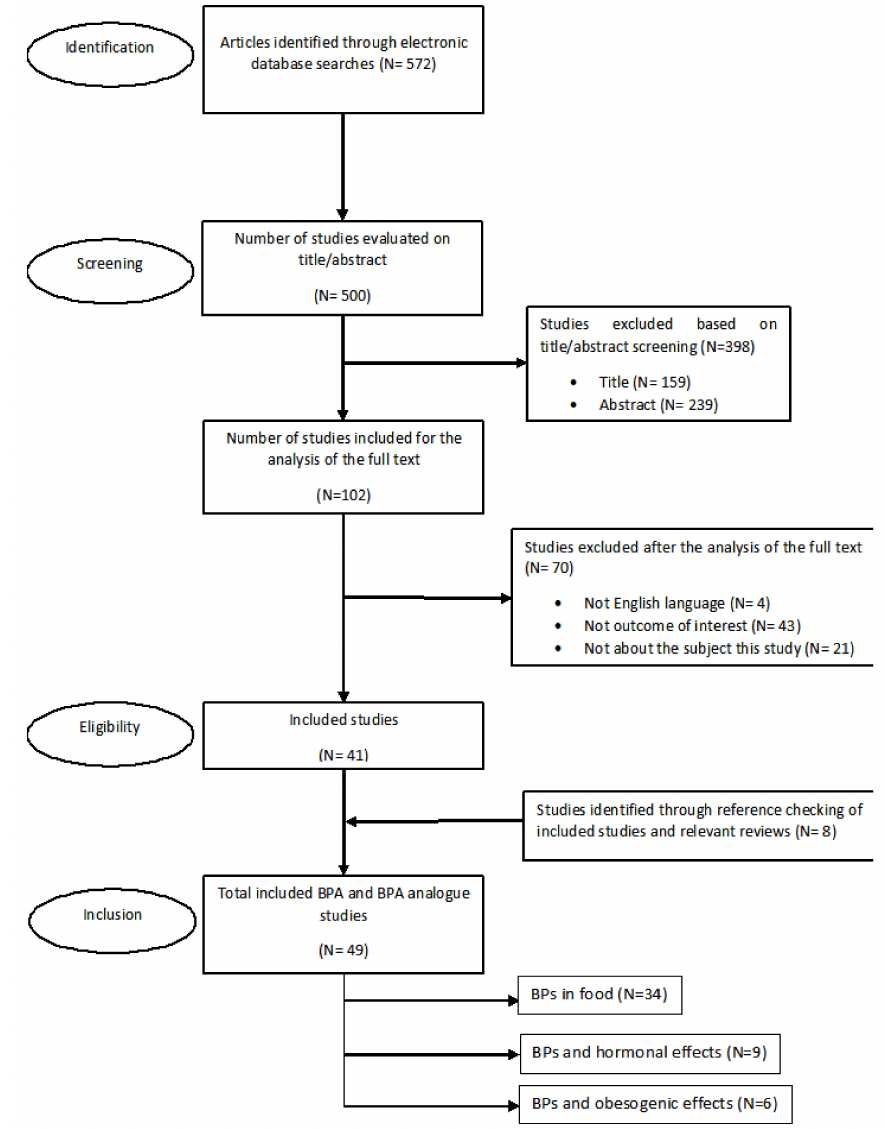
Figure 2. PRISMA flow diagram of the literature